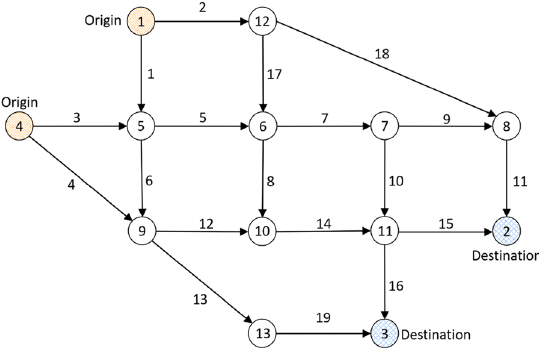
Fig. 2 Nguyen-Dupuis network (Nguyen and Dupuis 1984)